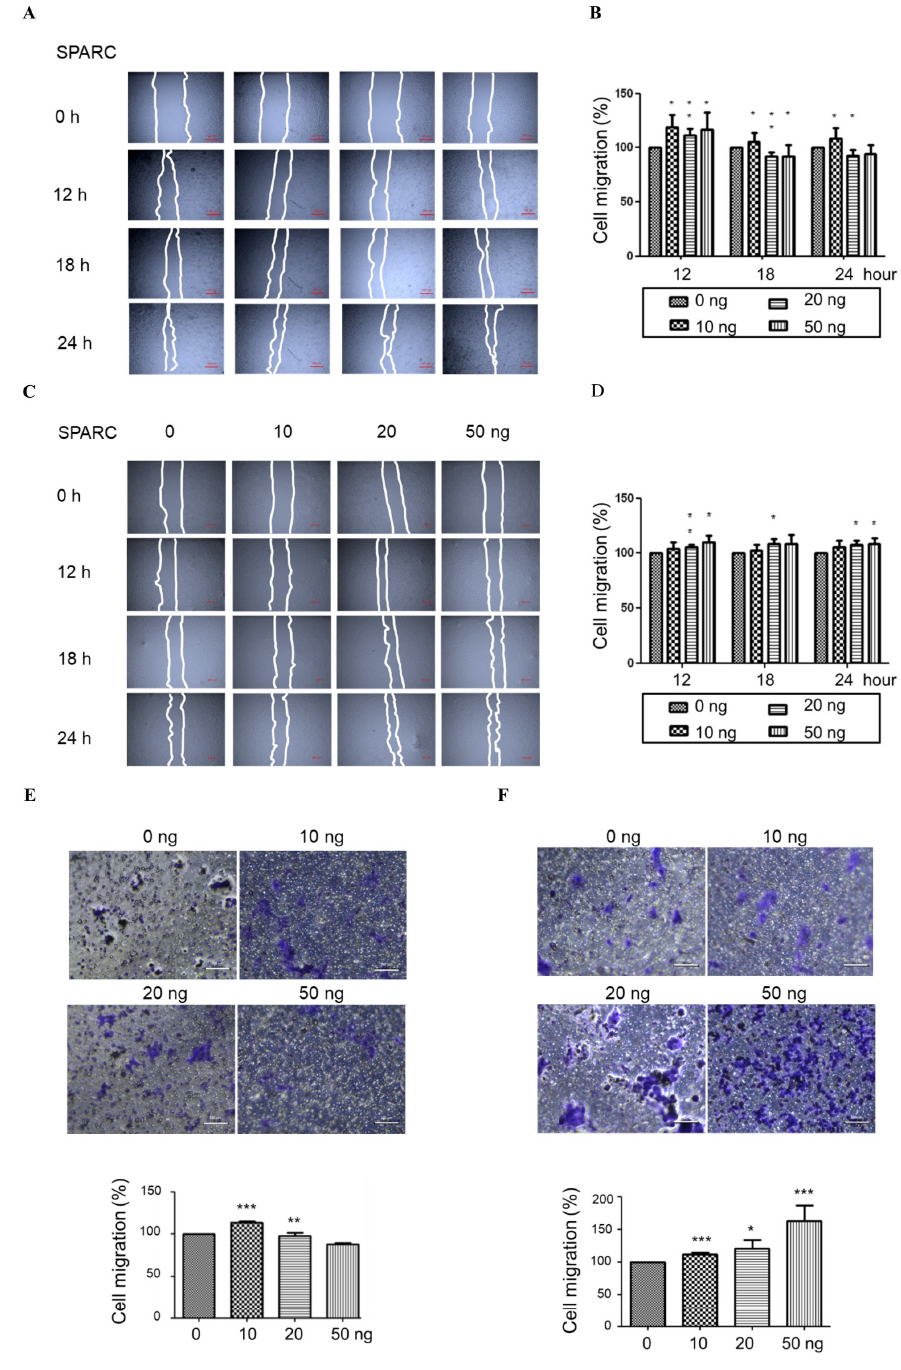
Figure 2. SPARC treatment promoted cell migration. ( A ) images of wound healing assay; ( B ) quantification of wound healing assay in FaDu cells; ( C ) images of wound healing assay; ( D ) quantification of wound healing assay in Detroit 562 cells; ( E ) transwell migration assay in FaDu cells and ( F ) Detroit 562 cells. Quantification results were shown in the lower panel and images were shown in the upper panel. The error bars represent SD ( t -test; * p < 0.05, ** p < 0.01, *** p < 0.001, when compared with 0 ng